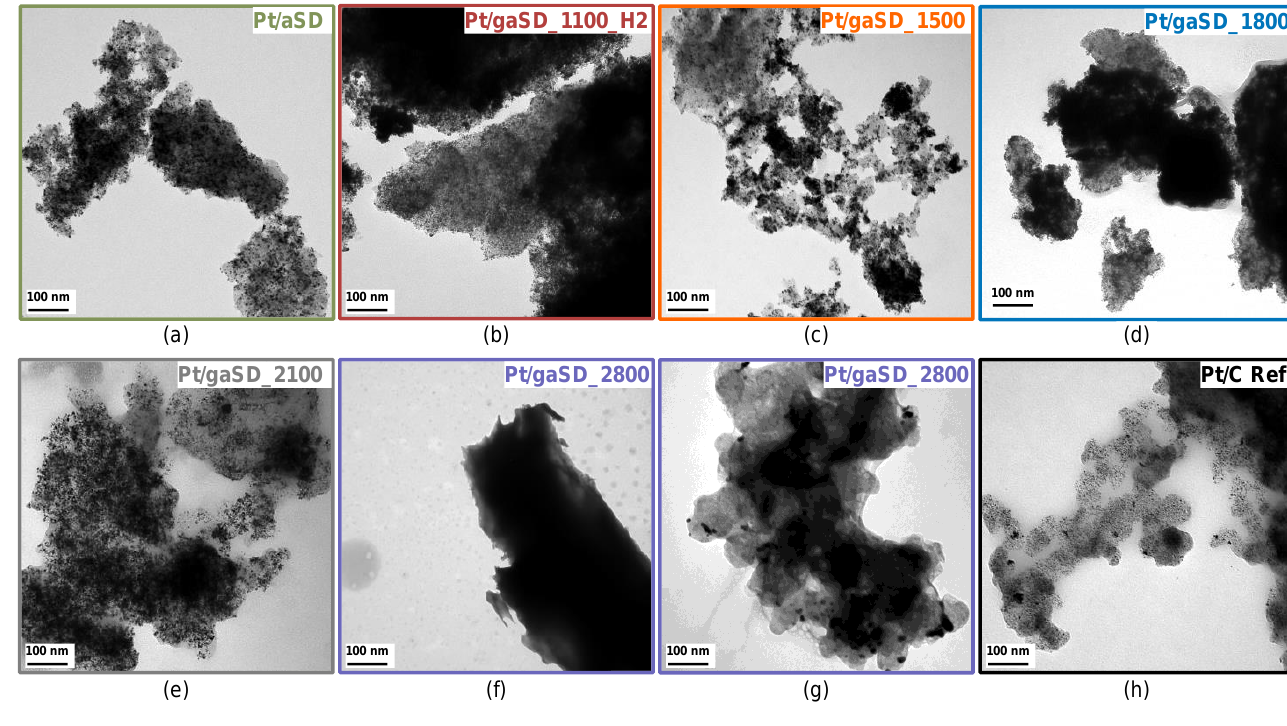
Figure 5. Transmission electron micrographs of Pt catalysts: Pt/aSD ( a ), Pt/gaSD_1100_H2 ( b ), Pt/gaSD_1500 ( c ), Pt/gaSD_1800 ( d ), Pt/gaSD_2100 ( e ), Pt/gaSD_2800 ( f , g ) and Pt/C ref ( h ). Table 1. Nanoparticle diameter and platinum content of catalysts, obtained from TEM images and ICP-MS